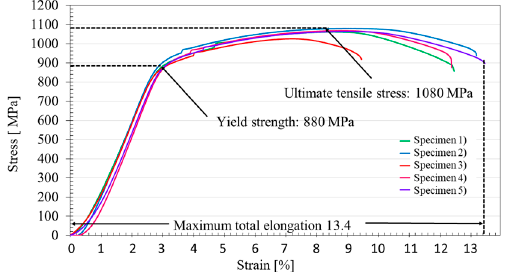
Figure 21. Stress-strain curve for five tested volumes built up with EHLA.